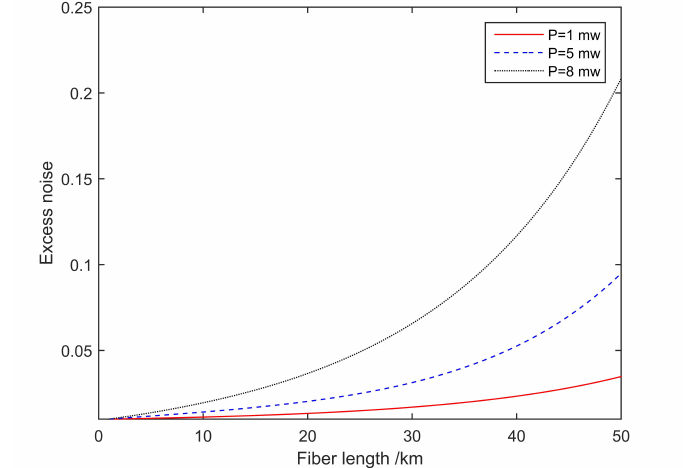
Figure 7. Noise induced by Trojan horse attacks with various input powers in homodyne